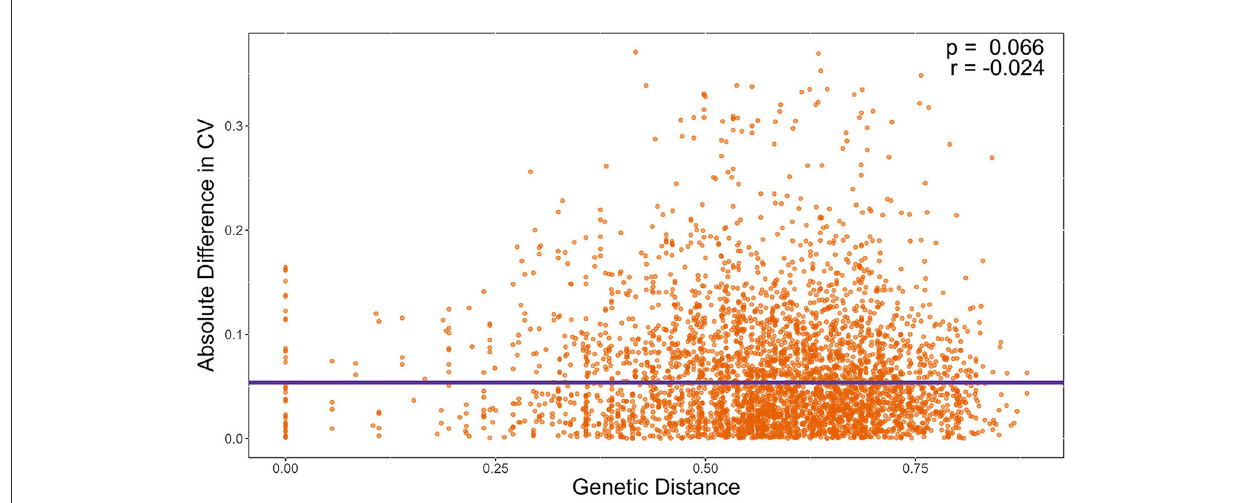
FIGURE9 Genetic distance is not significantly correlated with the coefficient of variation (CV) in growths among temperatures. X-axis refers to pairwise genetic distance between strains based on Bruvo’s distance. Y-axis refers to pairwise absolute difference in CV on Day 3. Significance was determined through a linear regression